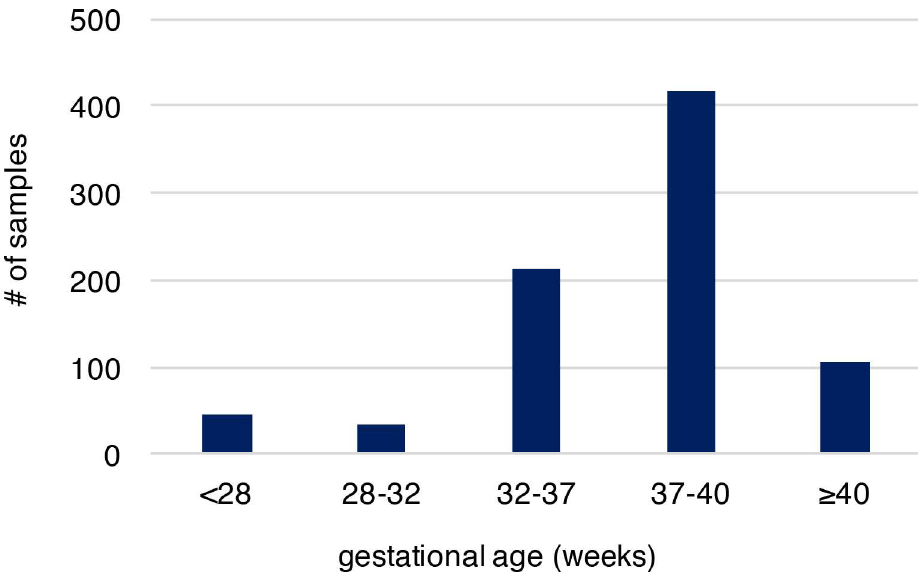
Fig 1. The gestational age distribution of the study participants. Preterm birth is considered if gestational age is less than 37 weeks. The cohort includes292 preterm newborns and 524 newborns at term. Gestational age is by